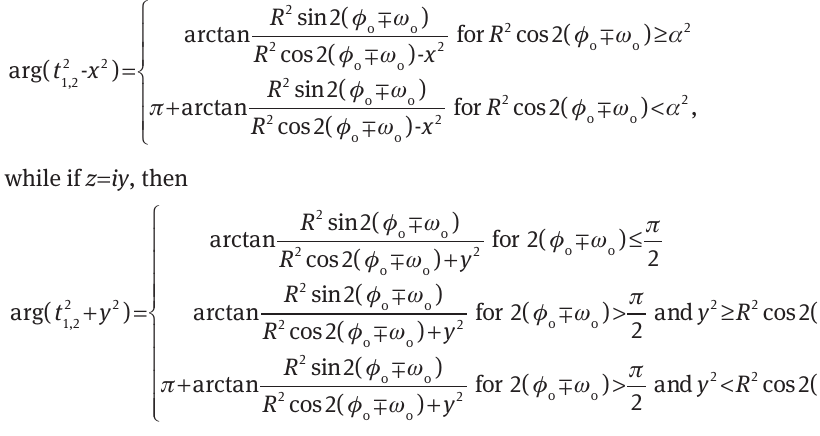
Figure 7 The variation of the stress components along the (A) x - and (B) y -axis for the case with f